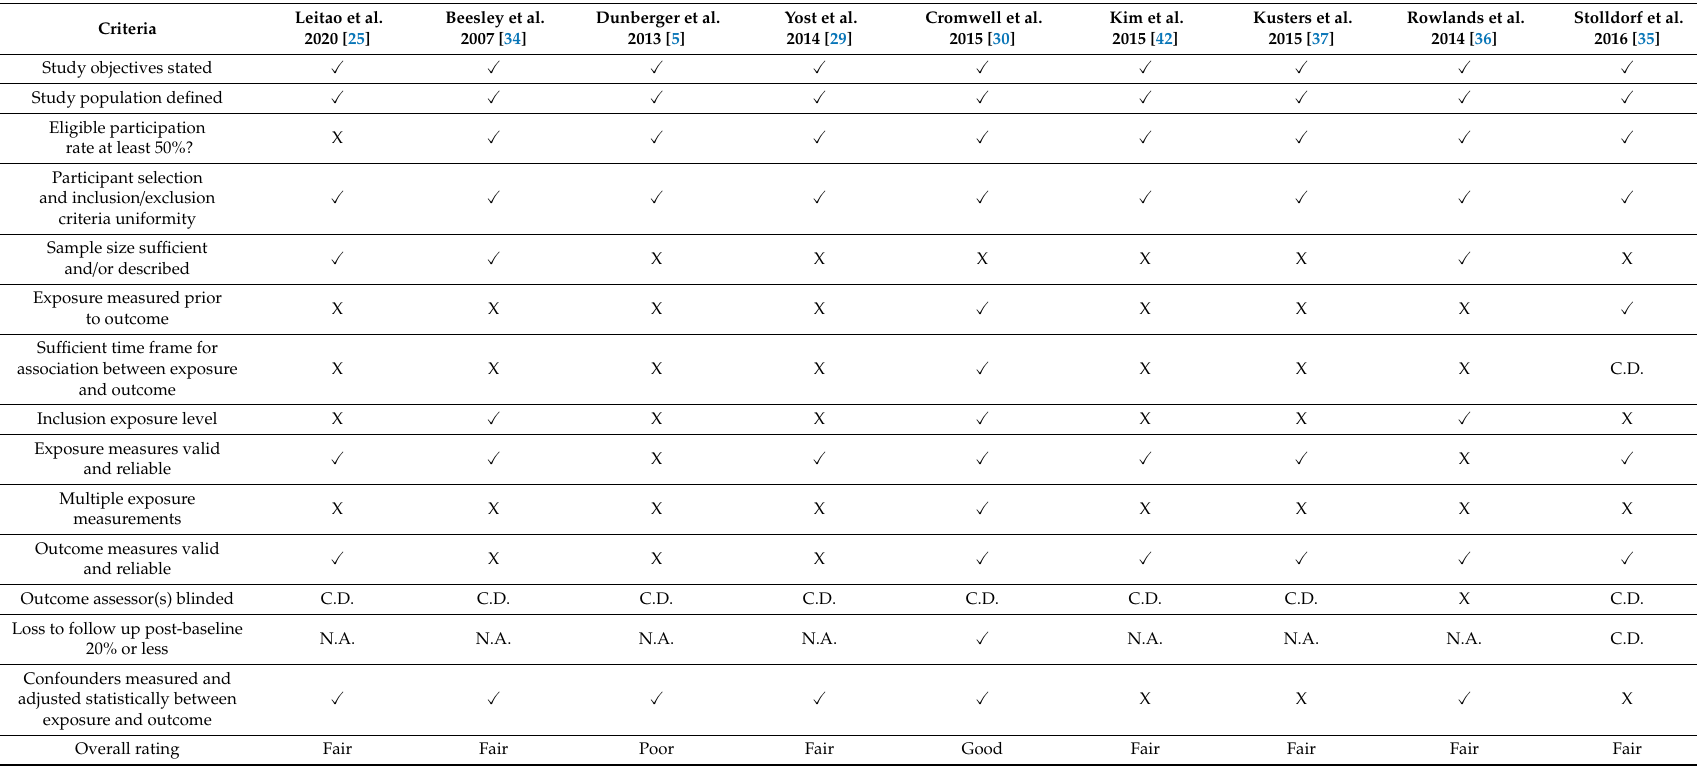
Table 2. NIH Quality Assessment for Observational Cohort and Cross-Sectional Studies